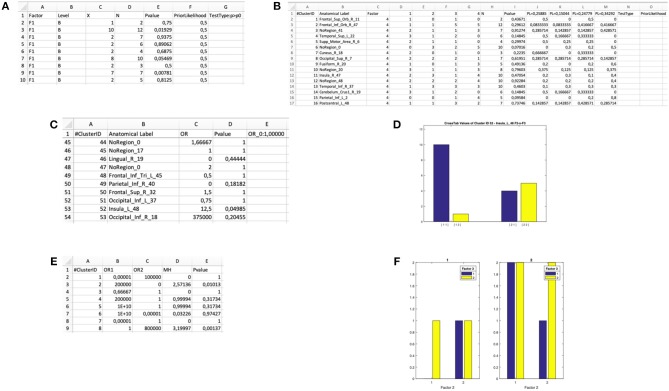
Output files of the “Cluster Composition Analysis” module and ensuing statistical inferences. (A) Output .xls file for a “binomial test” on the Level B of Factor F1. (B) Output .xls file for a “multinomial test” on Factor F4. (C) Output .xls file for a “Fisher's test” for 2 × 2 interaction of the Factors F2 and F3. (D) Bar plot generated by the “Fisher's test” procedure for 2 × 2 interactions in the Cluster Composition Analysis module. (E) Output .xls file for a “Mantel-Haenszel test” for 2 × 2 × 2 interaction of the Factors F1, F2, and F3. (F) Bar plot generated by the “Mantel-Haenszel test” for 2 × 2 × 2 interactions in the Cluster Composition Analysis module.